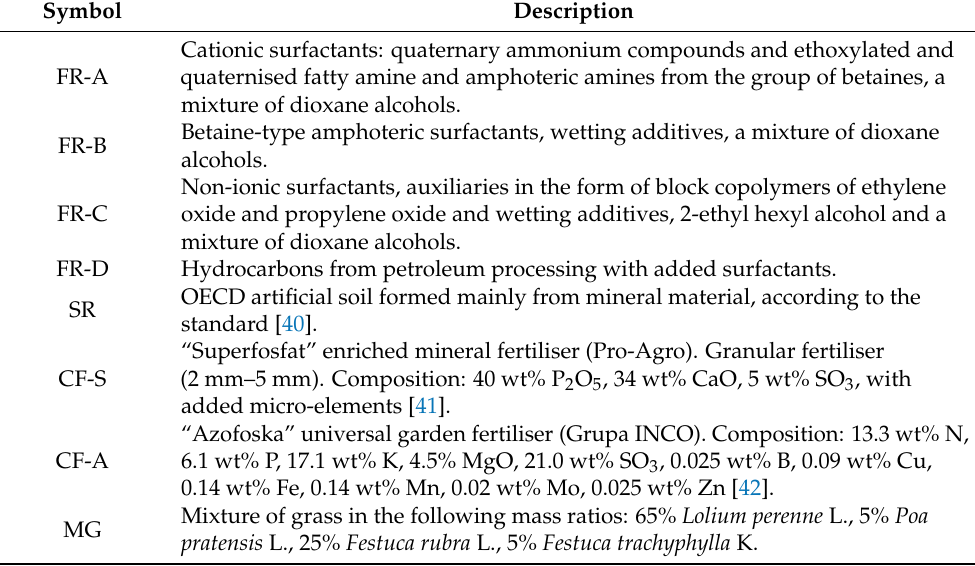
Table 1. Materials used in the